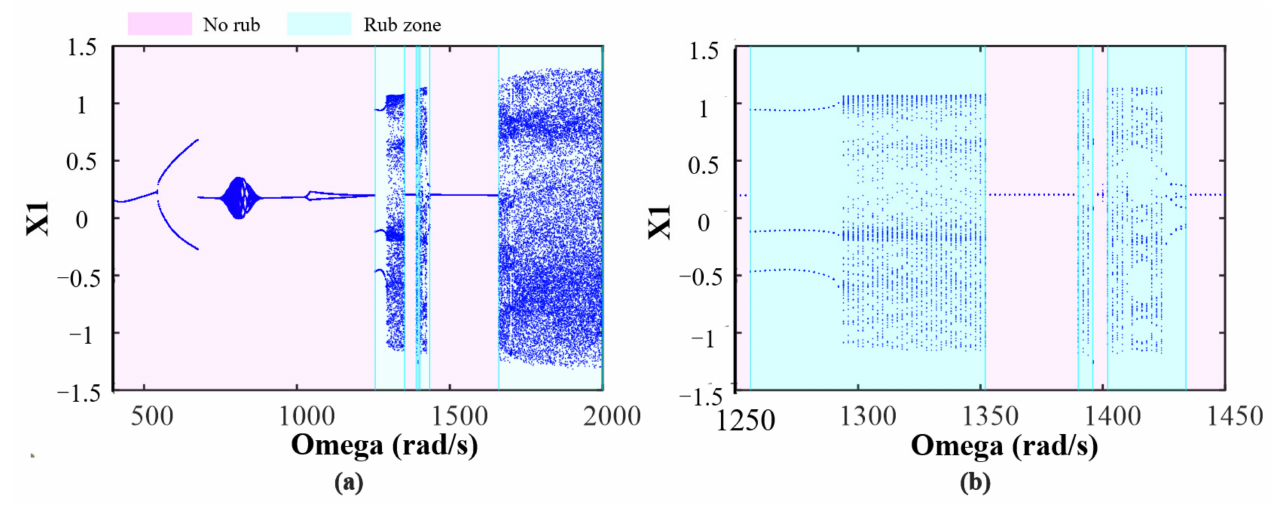
Figure 15. Bifurcation diagrams of the rotor system at the position of disc 1 for the case of disc 3 subjected to rub-impact: ( a ) ω = [400~2000] rad/s; ( b ) Local bifurcation